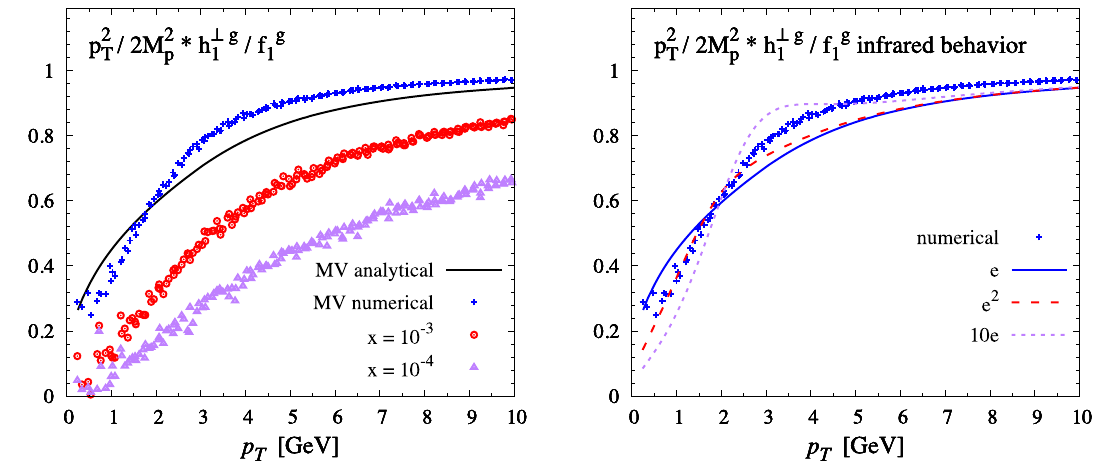
Fig. 7 Left: ratio of the linearly polarized vs unpolarized Weizsäcker–Williams gluon TMDs in the analytical MV model (solid line), as well as in the numerical simulation of Ref. [18]. Right: the dependence of this ratio on the choice of IR regulator